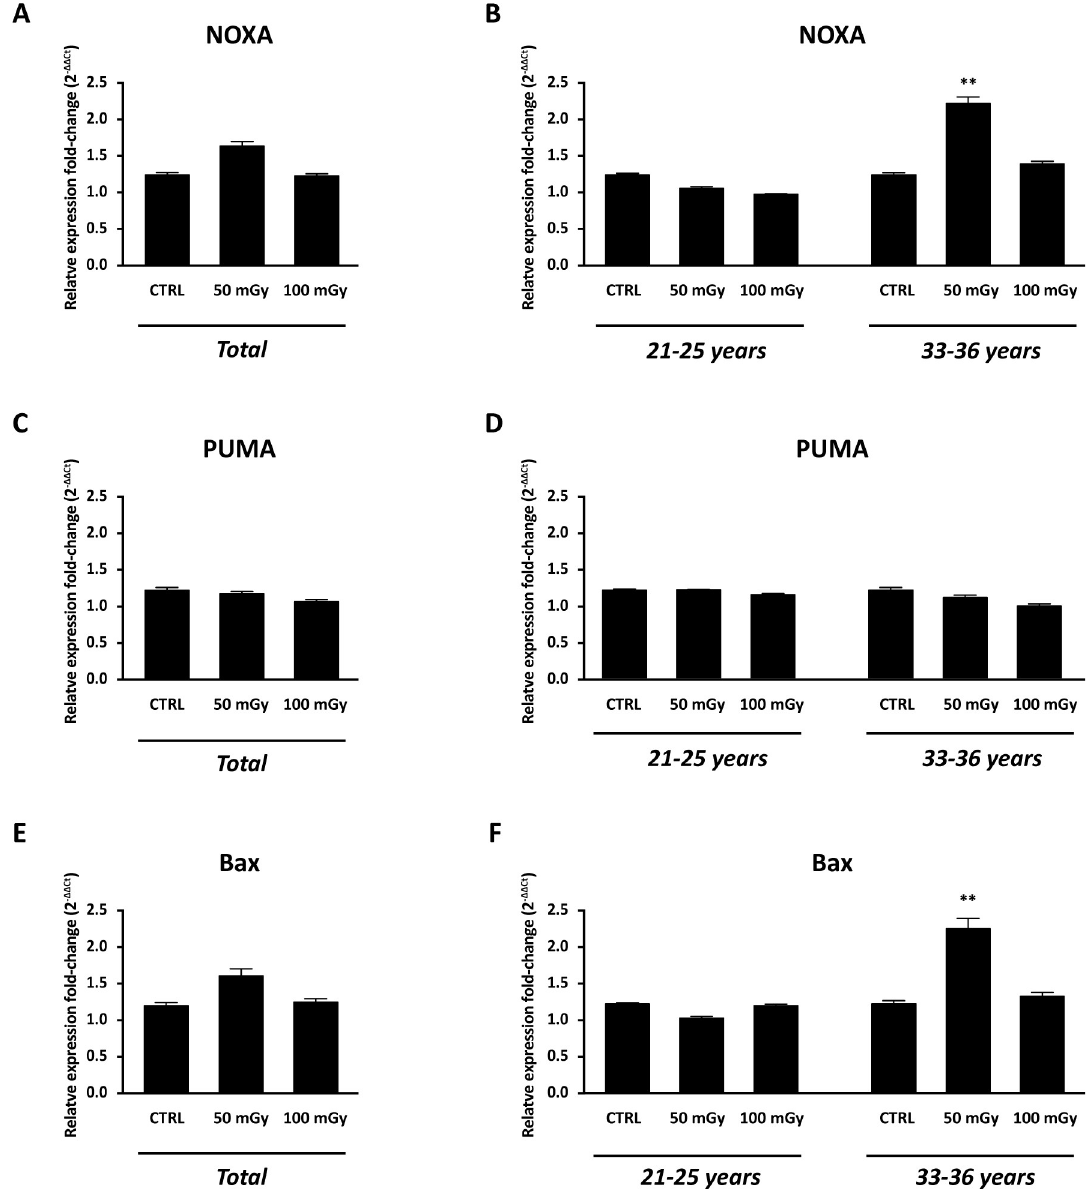
Fig 7. Apoptosis evaluation in human ovarian tissue exposed to X-radiation (50 mGy and 100 mGy). Real-Time PCR analysis for NOXA (A, B), PUMA (C, D) and Bax (E, F) mRNA expression. (A, C, E) Graphs report combined data from ovarian cortex derived from all 6 patients. (B, D, F) Data organised on patients’ age. CTRL: human ovarian tissue not exposed to x-radiation. Data are shown as mean ± SEM. ANOVA of 50 mGy and 100 mGy groups vs control: �� P < 0.01. CTRL: human ovarian tissue not exposed to X-ray